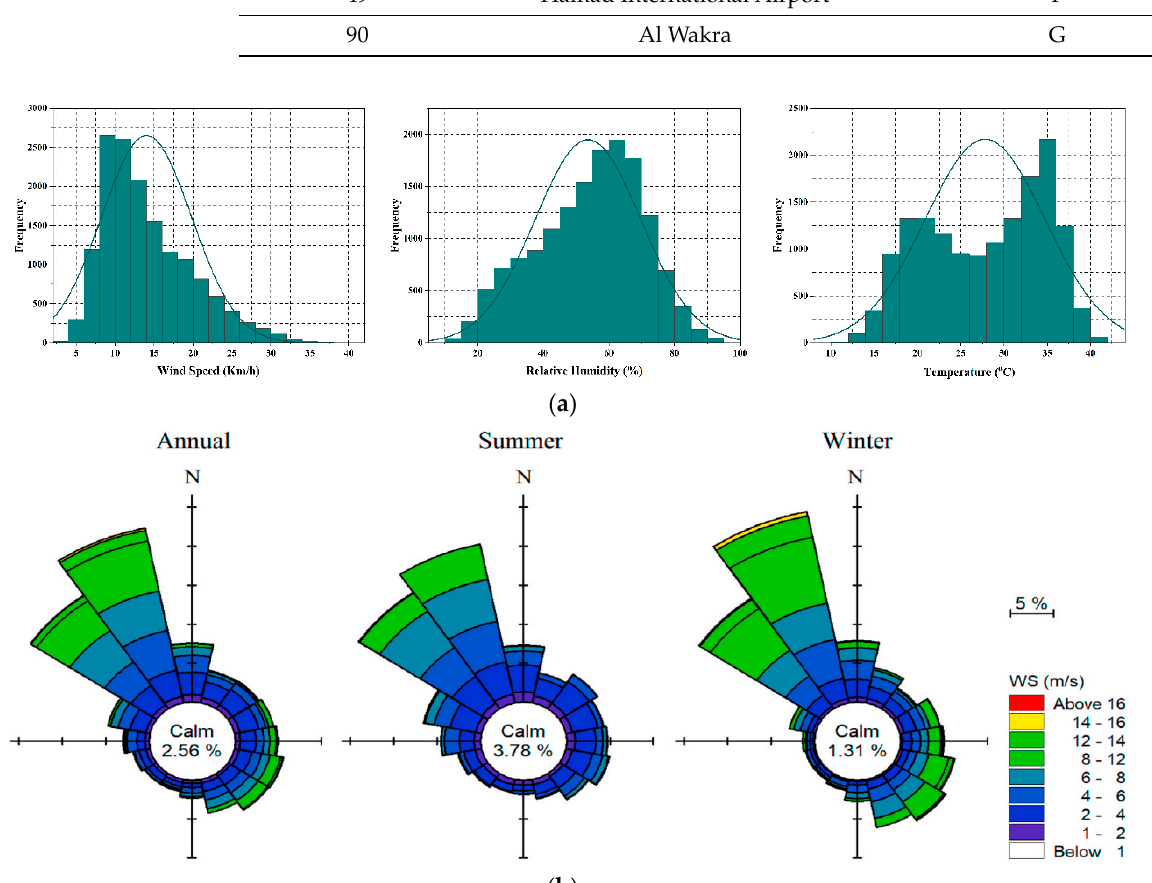
Figure 3. ( a ) Annual wind speed, relative humidity, and temperature in Qatar, ( b ) annual wind speed off Fuwairit in 2019